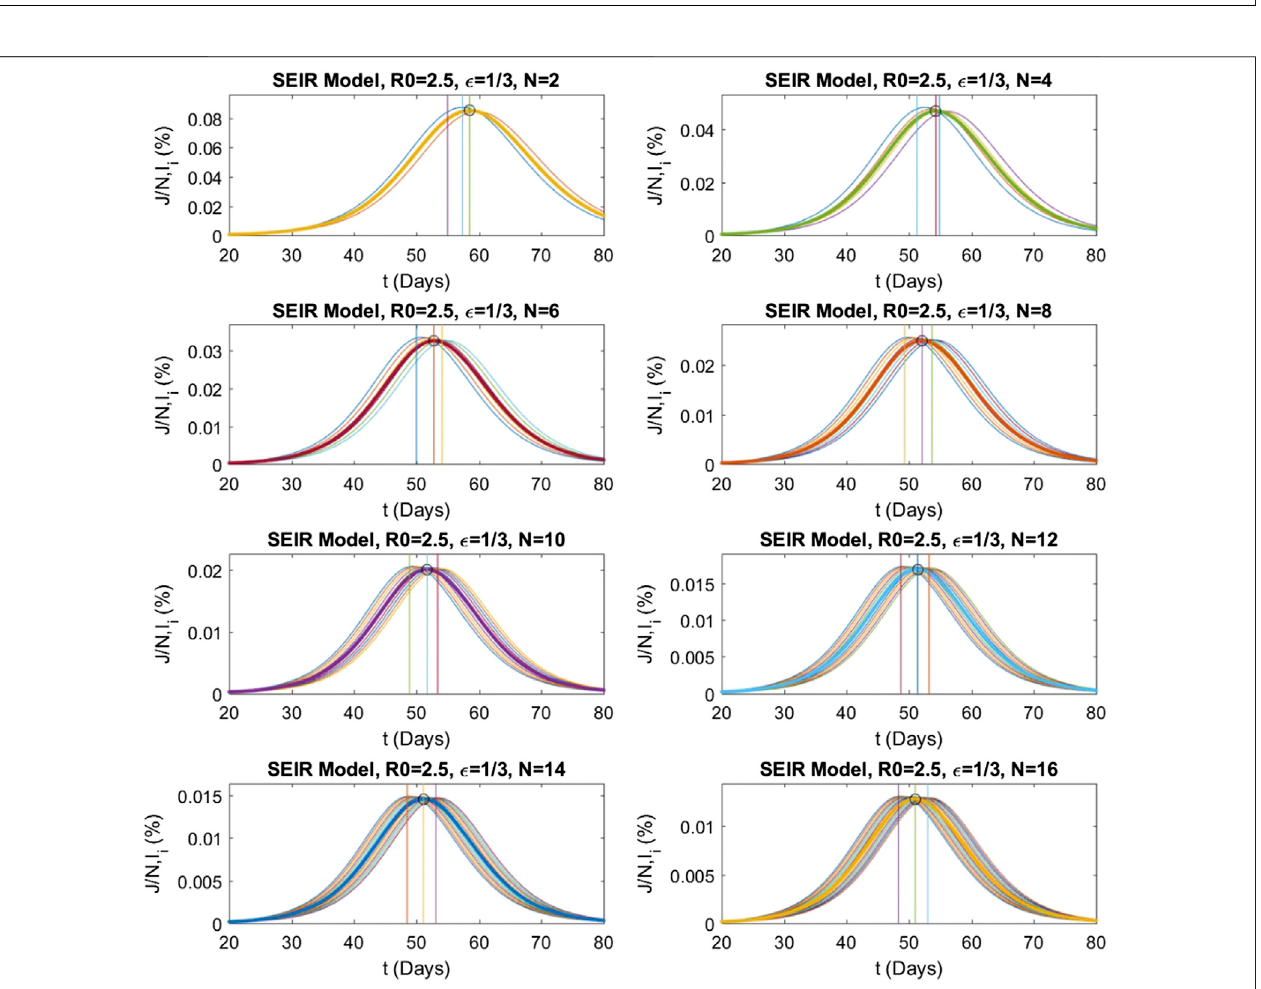
FIGURE 11 | Change of the position of maximum of J / N (normalized J ) in time with respect to the number of stages N for the multistage SEIR model. “ o ” indicates the position of the maxima of J / N (thick curves). Vertical lines represent the position of maximum points of the fi rst stage, J / N , and the last stage, respectively.